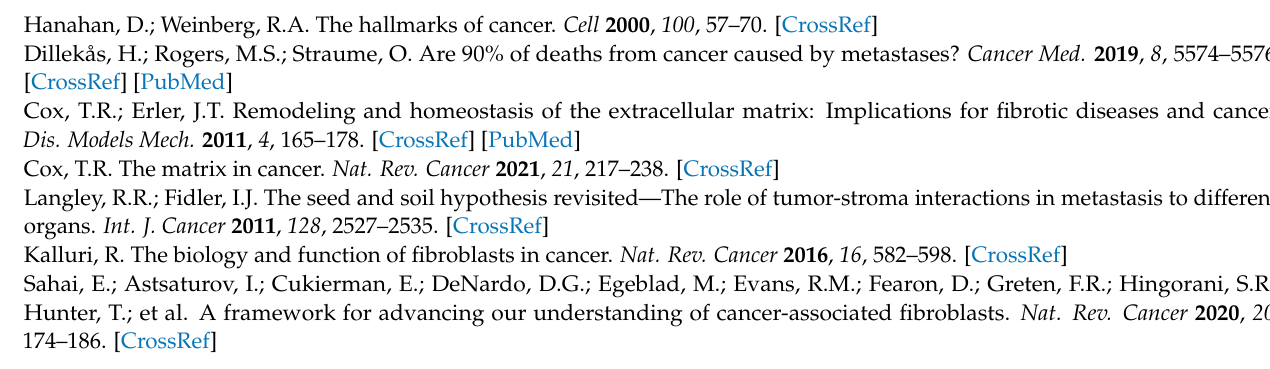
Table S6: Tyrosine peptide analysis of breast cancer cell responses to fibroblast-derived matrices, Serine and threonine peptide analysis of breast cancer cell responses to fibroblast-derived matri- ces, Table S7: Tyrosine peptide analysis of breast cancer responses to fibroblast-derived matrices, Serine/Threonine analysis of breast cancer responses to fibroblast-derived